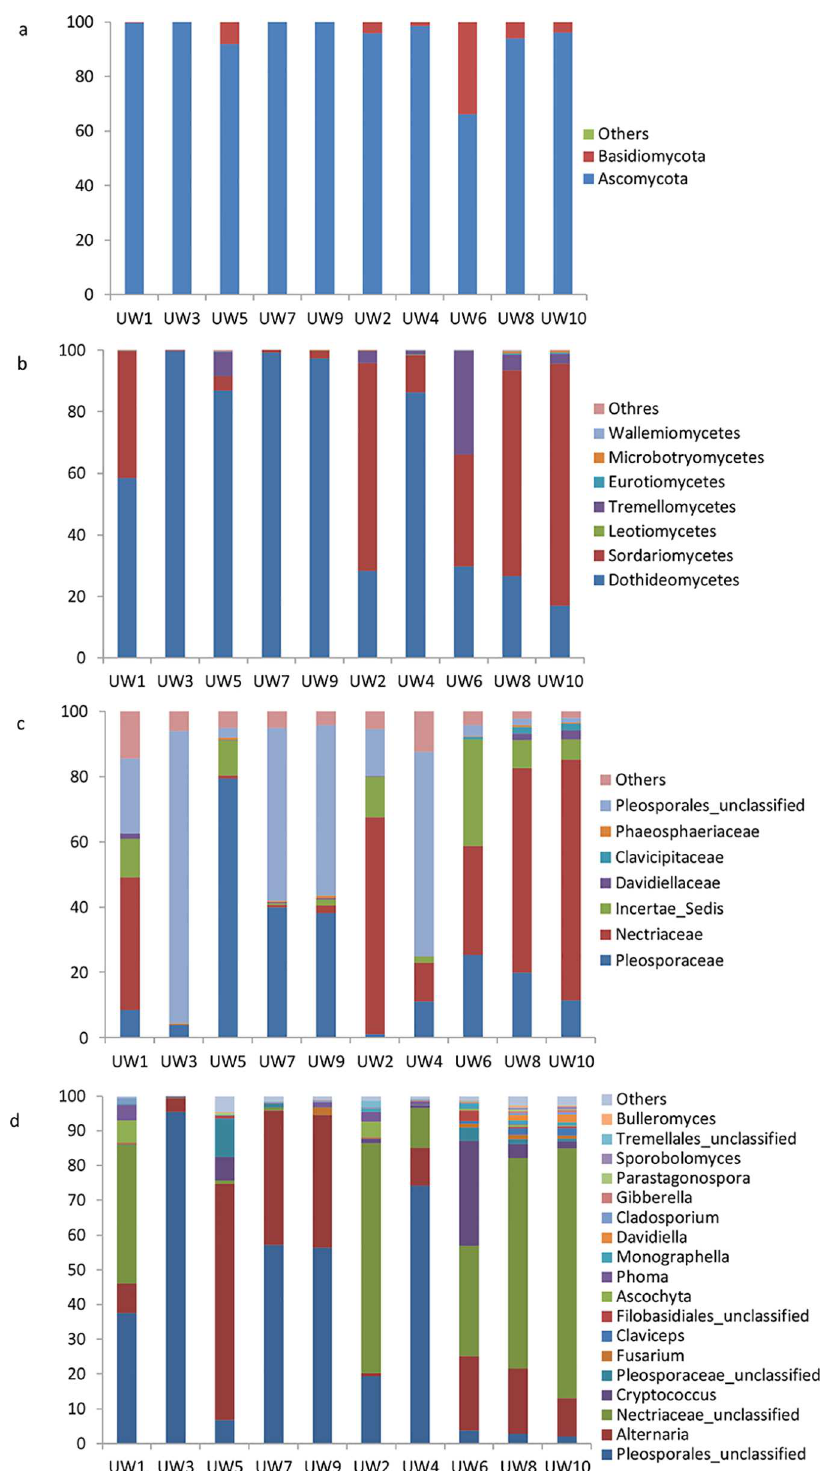
Fig 3. Relativeabundances of the dominant fungalphyla (a), fungal classes (b), fungal family (c) and fungal genus(d) for each sample. Relativeabundances are based on the proportional frequenciesof the DNA sequencesthat could be